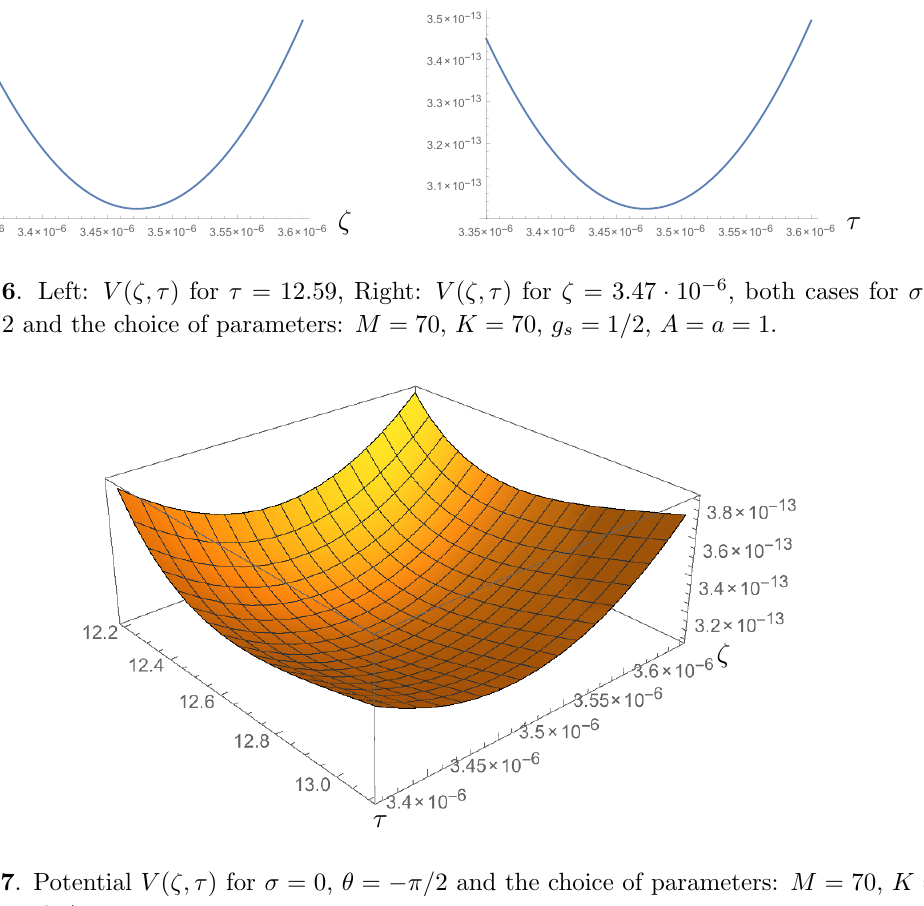
Figure 7 . Potential V ( (cid:16); (cid:28) ) for (cid:27) = 0, (cid:18) = (cid:0) (cid:25)= 2 and the choice of parameters: M = 70, K = 70, g s = 1 = 2 and A = a =